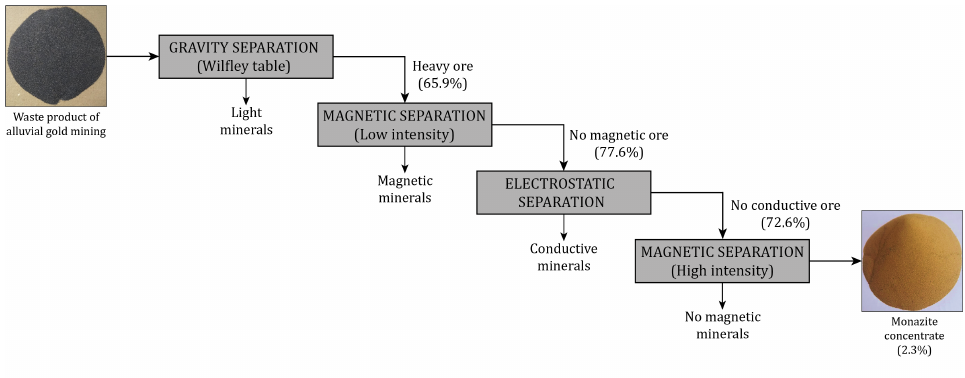
Figure 4. Flowsheet for concentrating monazite from alluvial gold mining residue. (Done by the